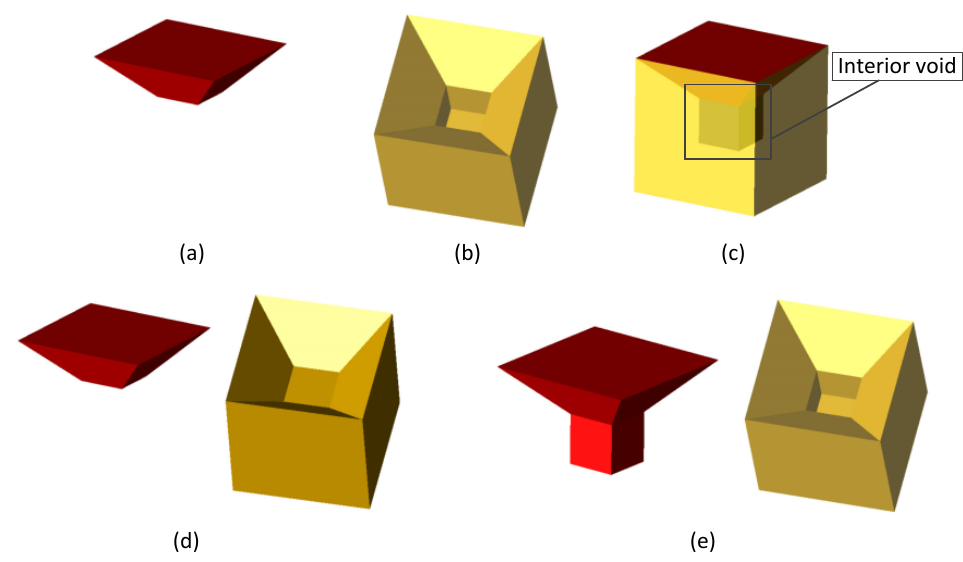
Figure 1. Repairing examples of the multi-labeled triangular mesh: ( a , b ) the input meshes; ( c ) an interior void combined by the input meshes; ( d , e ) the repaired results.